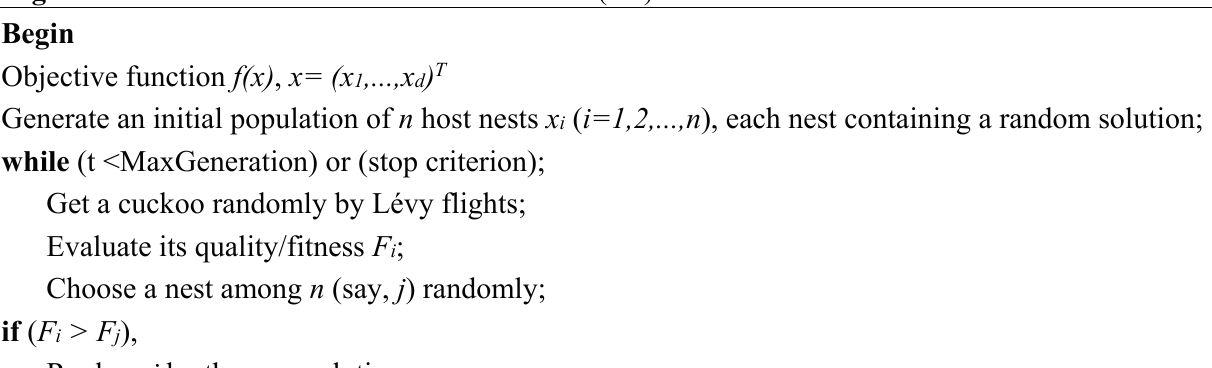
Algorithm 1. Pseudo code of the Cuckoo Search